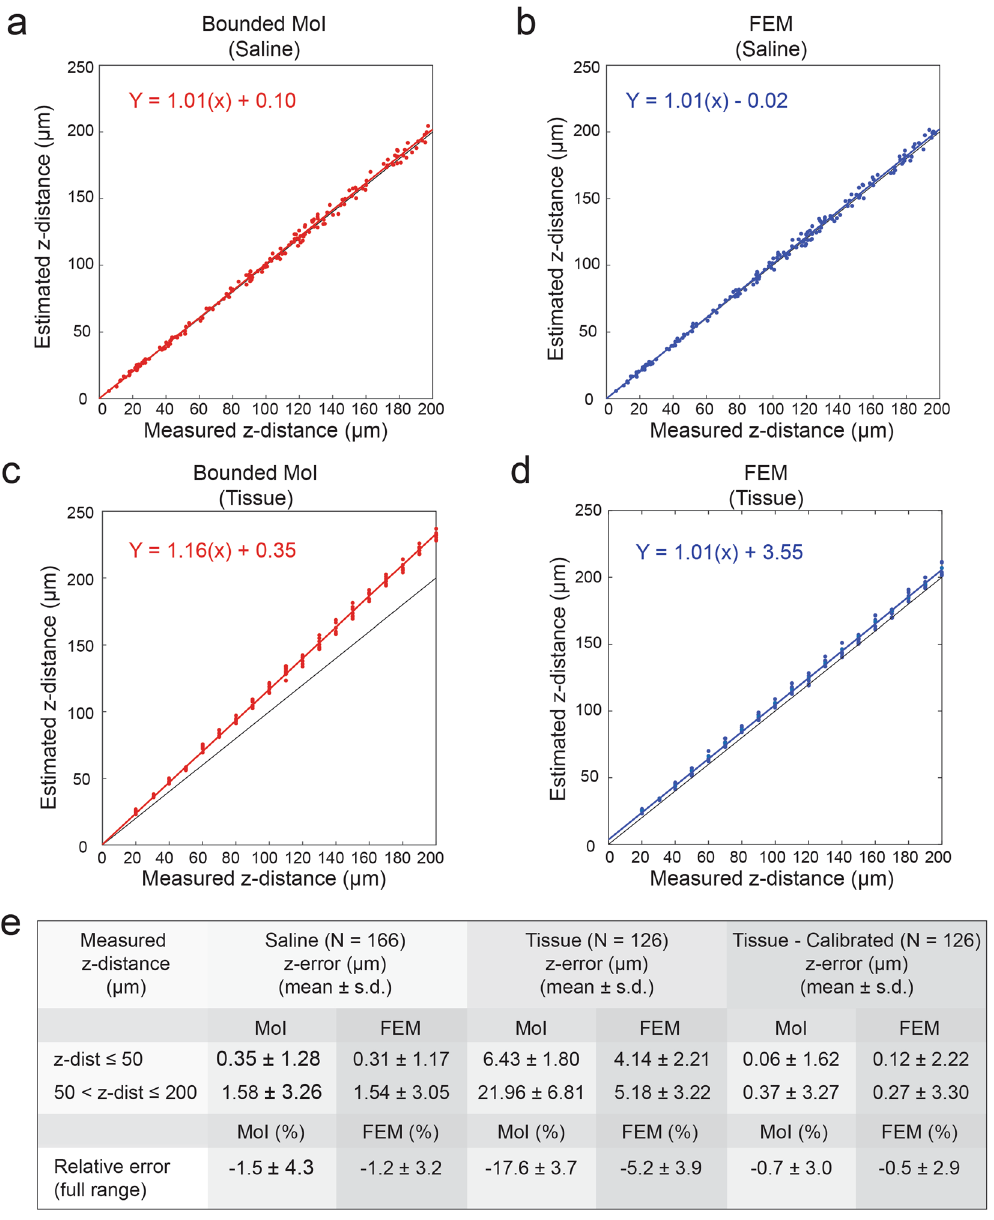
Figure 6. Localization performance along the z-axis. Accurate z-localization of a point source in saline N = 166 ( a , b ) and in an acute brain slice N = 126 ( c , d ) can be achieved using HD-MEA models. For each measurement, the estimated z-distance of the pipette is plotted against the measured z-distance. Estimates were based on the MoI model (red dots in a and c ) and FEM (blue dots in b and d ). The measured values refer to the programmed movement of the micromanipulator, which was confirmed visually by microscopy when possible. In ( c , d ), the location of the micropipette could not be monitored by microscopy so that only the micromanipulator movement was used as reference after a calibration step. Linear regression analysis was performed for both saline and tissue z-localization results for using MoI (red line) and FEM (blue line) models. The fitted regression lines indicate that FEM-based estimates are closer to measurement values as compared to MoI estimates. ( e ) Summary of z-errors computed by subtracting the measured z-distances (manipulator data, microscopy) from the estimated z-distances (FEM and MoI models). The mean values and standard deviations are